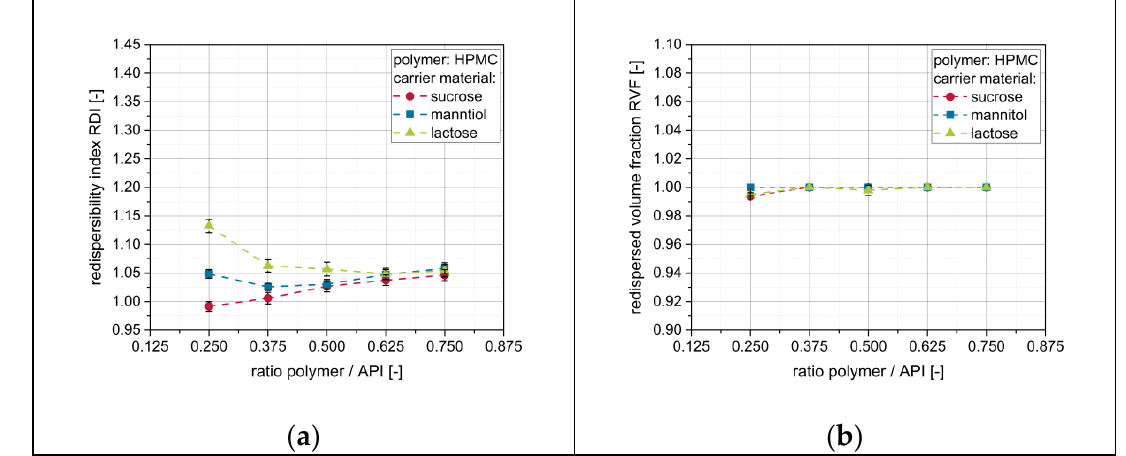
Figure 9. Effect of additional polymer (HPMC) in the granulation fluid on the redispersibility of HPMC/SDS-stabilized naproxen nanoparticles from granules produced with different carrier materials (lactose, mannitol, sucrose). Measurements of redispersed suspensions were carried out by means of ( a ) DLS and ( b ) LD.